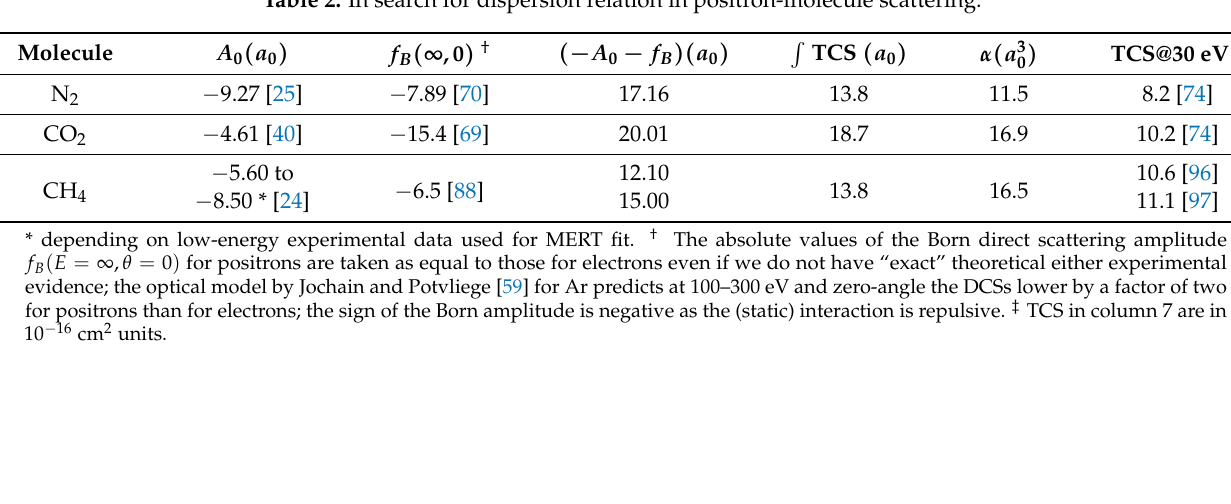
Table 2. In search for dispersion relation in positron-molecule scattering.